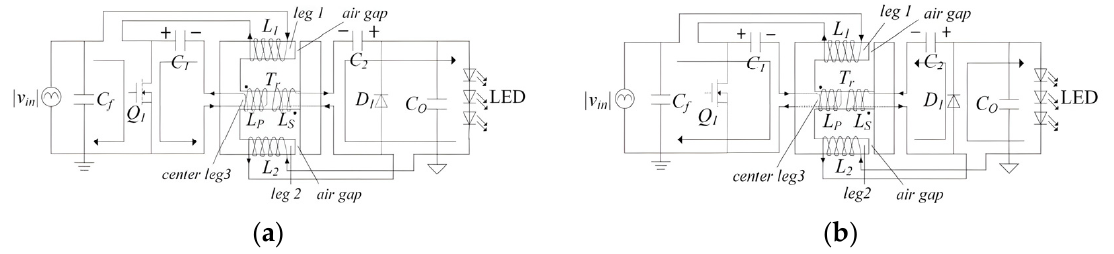
Figure 2. The equivalent circuit of the proposed LED driver. ( a ) [ t 0 – t 1 ]. ( b ) [ t 1 – t 2 ].